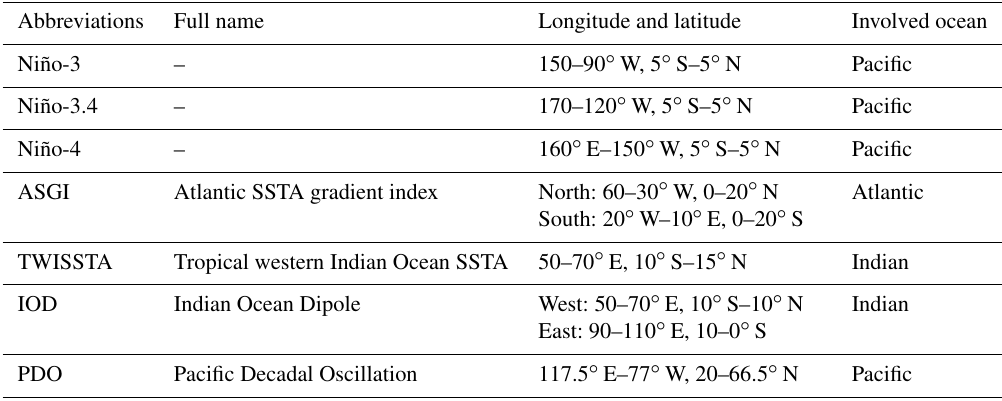
Table 1. Longitude and latitude of the SST index used in this